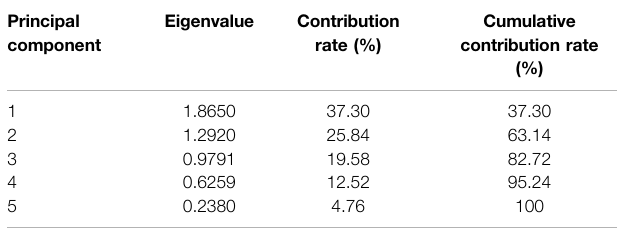
TABLE 3 | Correlation coef fi cients among the original prediction variables. TABLE 4 | Calculation results of PCA.